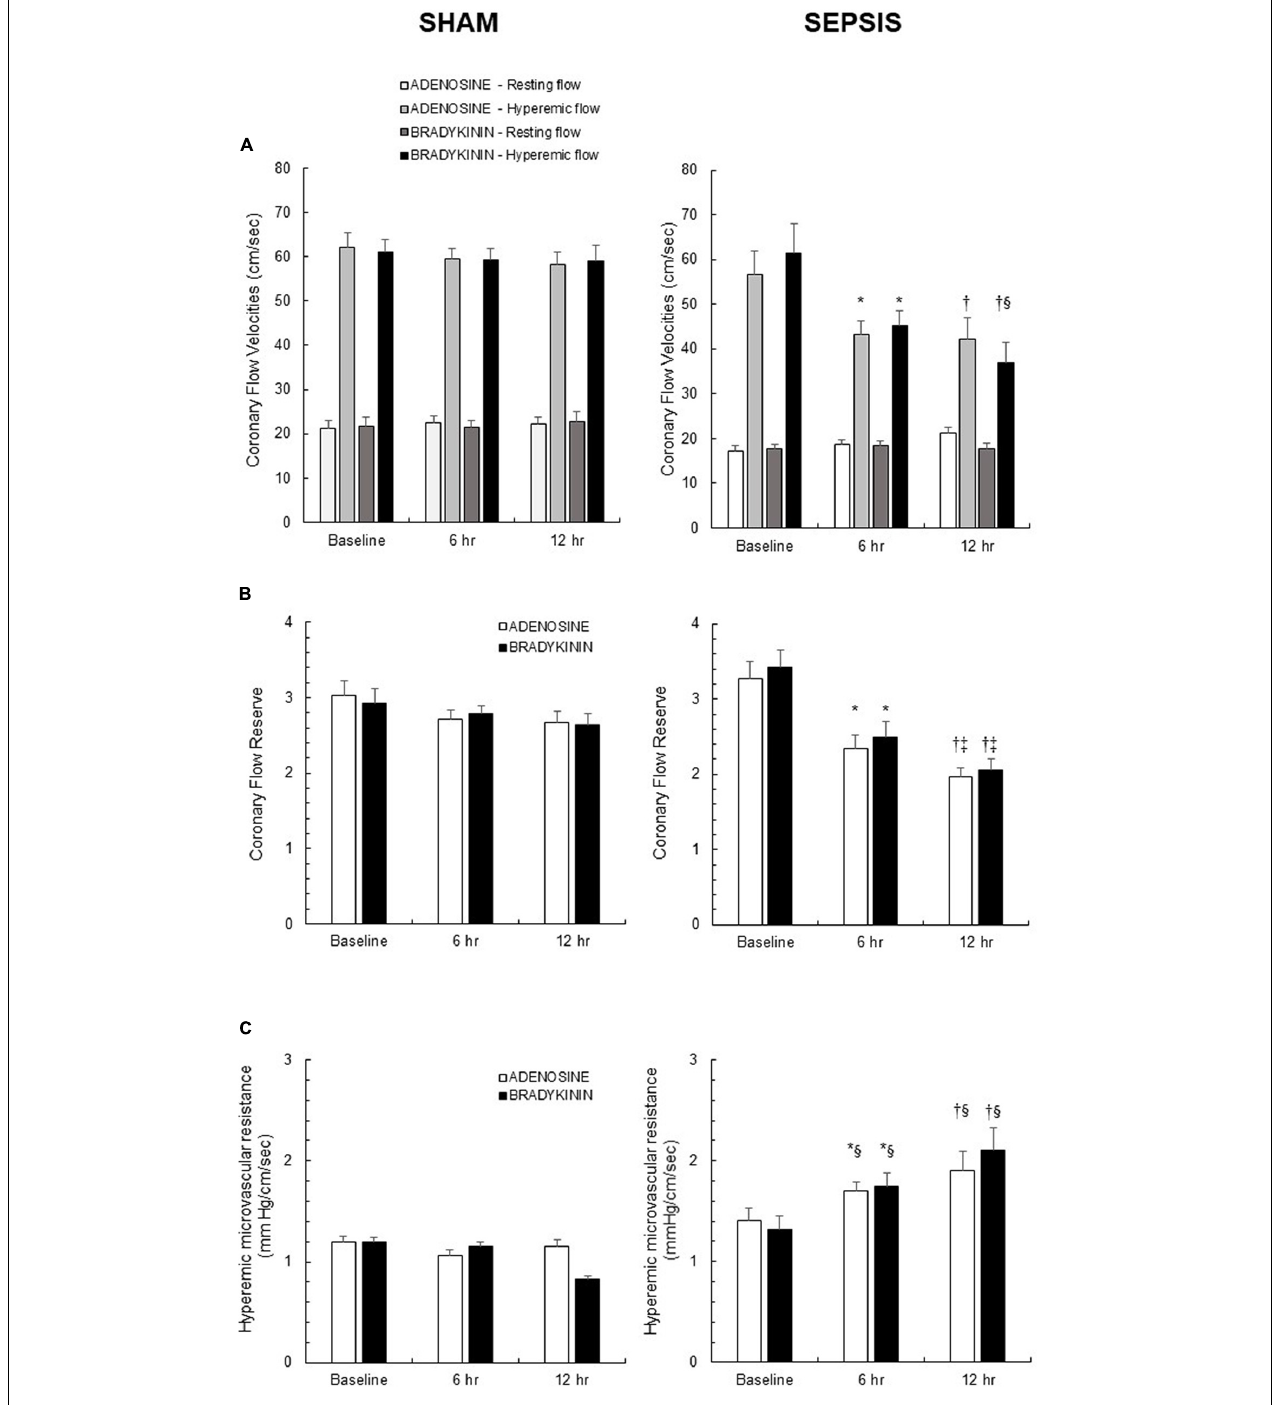
FIGURE 2 | In vivo coronary vasomotor response induced by endothelium-independent (adenosine) and endothelium-dependent (bradykinin) vasodilators. (A) Resting and hyperemic flows induced by administration of adenosine (white and light gray bars, respectively), and of bradykinin (dark gray and black bars, respectively) in sham (left panel; n = 7) and sepsis (right panel; n = 7) groups. (B) Coronary flow reserve, calculated as the ratio of hyperemic-to-resting flows and representing the metabolic adaptive mechanisms after adenosine (white bars) and bradykinin (black bars) administration in sham (left panel; n = 7) and sepsis (right panel; n = 7) groups. (C) Hyperemic microvascular resistance, calculated as the ratio of coronary pressure-to-hyperemic flow after adenosine (white bars) and bradykinin (black bars) administration in sham (left panel; n = 7) and sepsis (right panel; n = 7) groups. Results are expressed as mean ± SEM. * p < 0.05 6 h vs. baseline; † p < 0.05 12 h vs. baseline; ‡ p < 0.05 12 vs. 6 h after sepsis induction in the same group; § p < 0.05 sepsis vs. sham group for the same